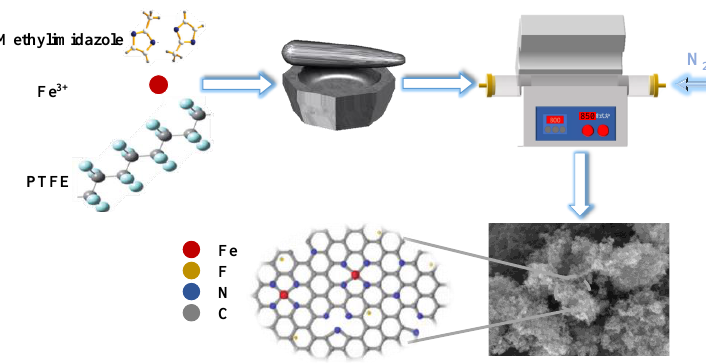
Scheme 1. Schematic representation of the preparation process of the 2P-Fe-X catalyst.